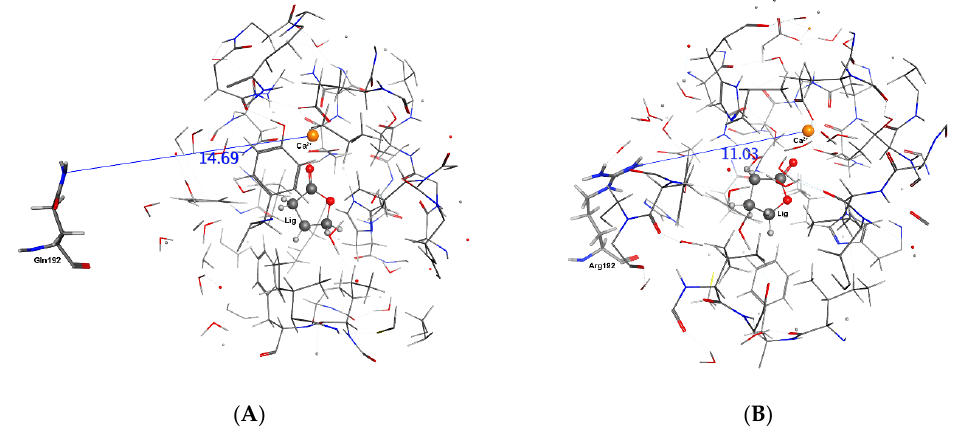
Figure 5. The distance between Glu192/Arg192 and Ca 2+ in the γ -Butyrolactone complexes after 20 ns. ( A ) QPON1. ( B ) RPON1. 20 ns. ( A ) QPON1. ( B )